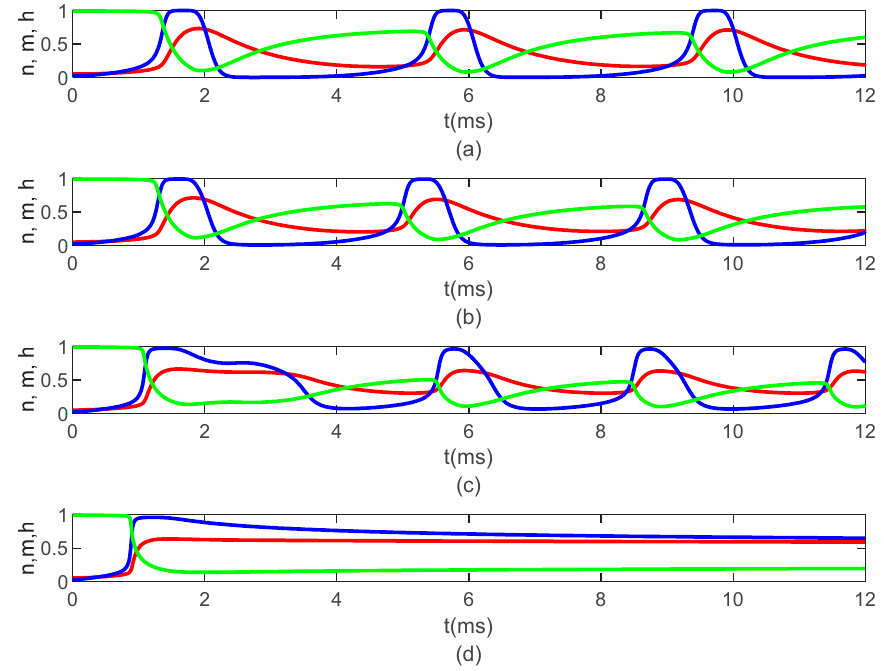
Figure 9. Time variations of the gating variables n ( t ) (red), m ( t ) ( blue), and h ( t ) (green), obtained by solving the fractional Hodgkin–Huxley Equations (35)–(38) for ( a ) β = 1, ( b ) β = 0.95, ( c ) β = 0.8, and ( d ) β = 0.66. Here, p = 0.25, q = 0.75, and α = 0.65.